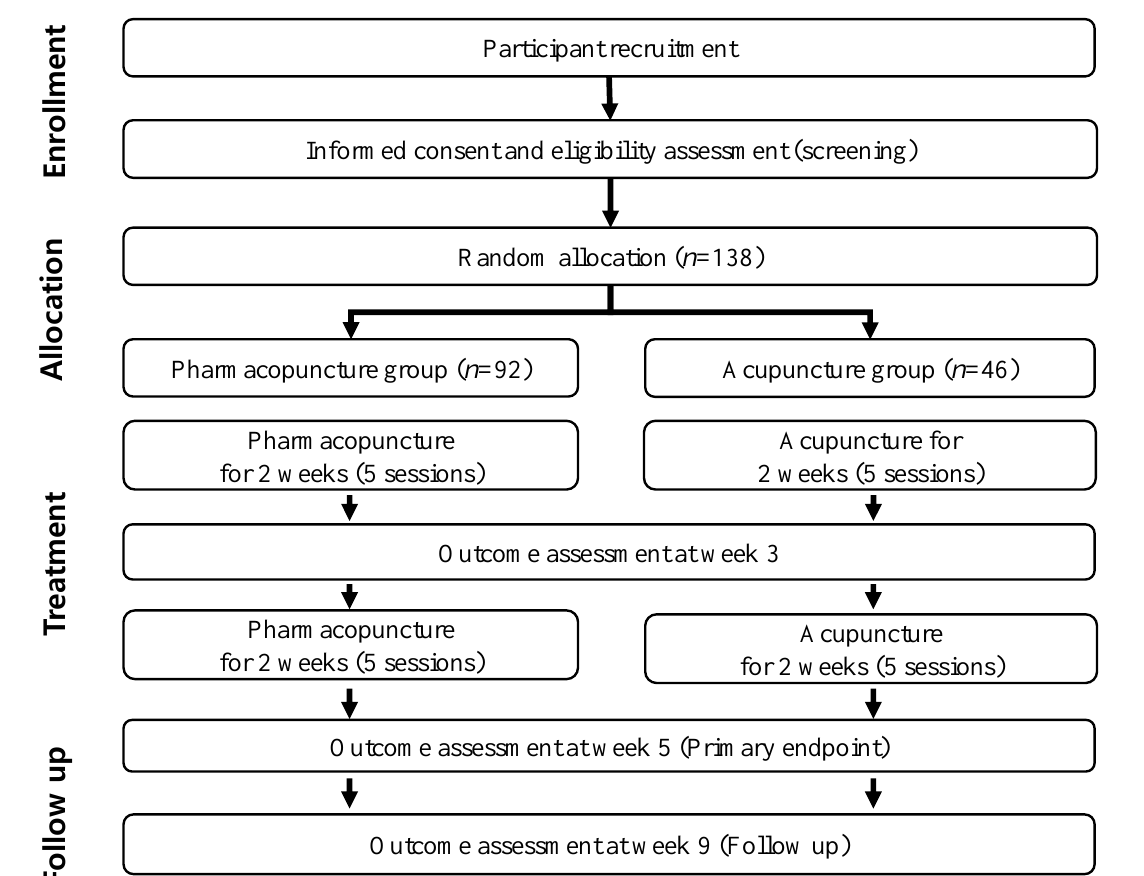
Figure 1. Flow diagram of the